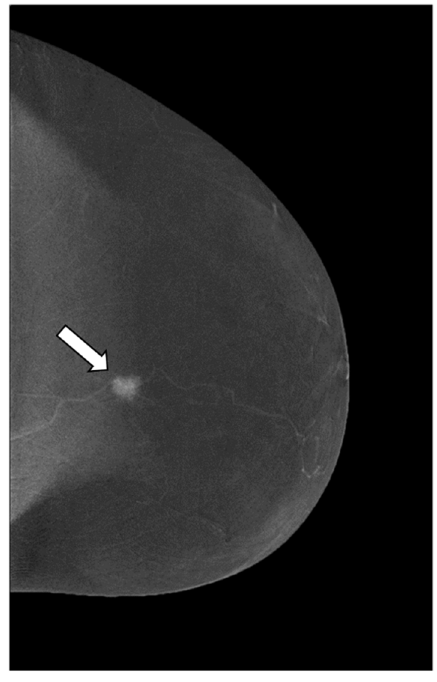
Figure 2. Craniocaudal (CC) view of CESM subtraction image of a 59-year-old patient with a suspicious lesion of the left breast measuring less than 10 mm (BI RADS 4c). The subtraction images show a mass enhancement marked, irregular, heterogeneous, and unpurified (enhancement score 4) (white arrow). The histological result is an invasive ductal carcinoma.